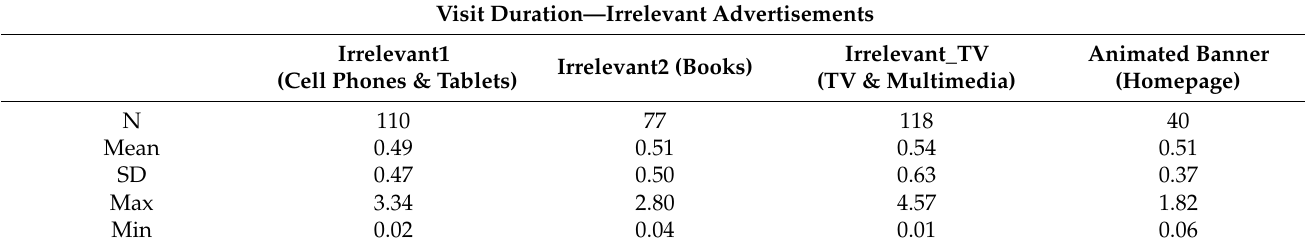
Table 7. Visit duration for irrelevant